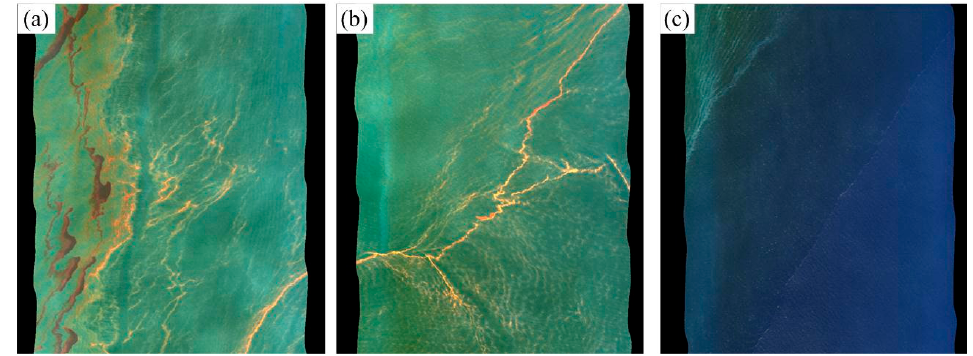
Figure 3. Three test areas extracted from the original hyperspectral image to validate the conclusion. Training areas are distinct from these test areas. Pictures ( a – c ) are false-color composited test images ( a – c ).